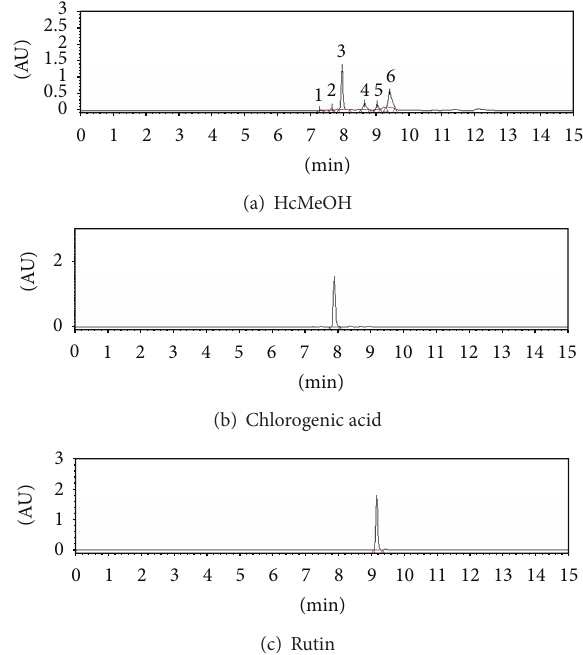
Figure3:HPLCchromatogramcomparisonbetweenHcMeOHand commercial standards. (a) Crude extract of HcMeOH; (b) chloro- genic acid commercial standard; (c) rutin commercial